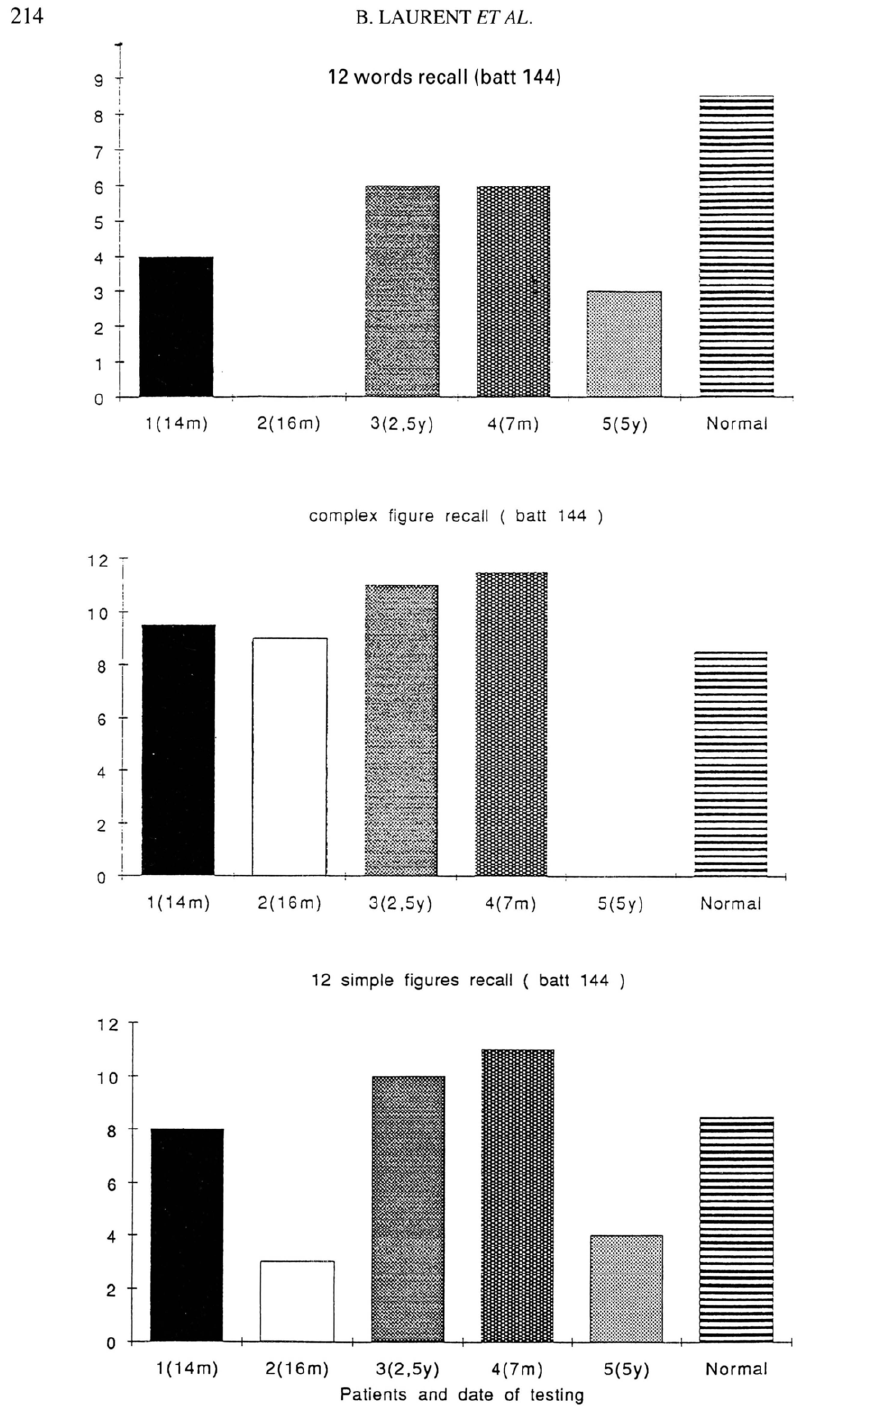
FIG. 2. Verbal and visual episodic memory in the five patients (memory battery 144 of Signoret) in parentheses the date of testing after encephalitis onset in months (m) or years